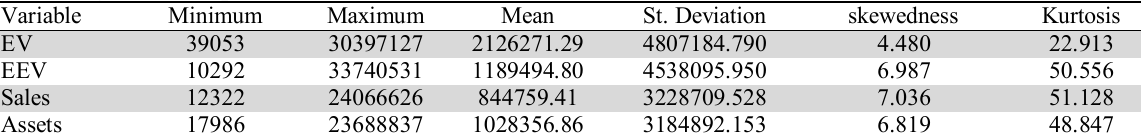
Summary of Description Results